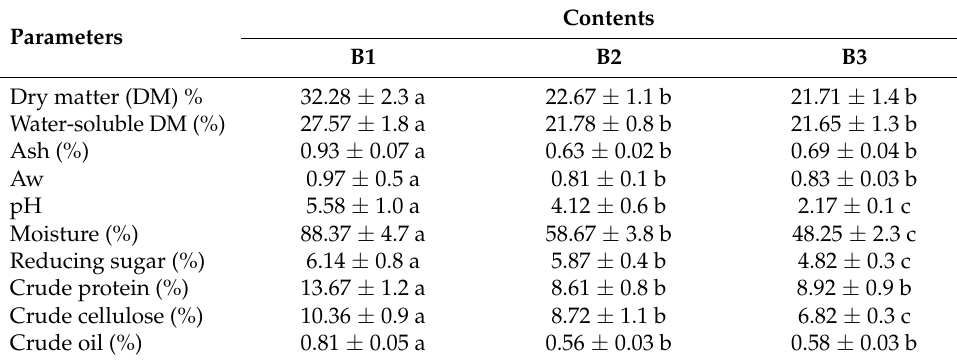
Table 3. Physiochemical profiles of berberis fruits.